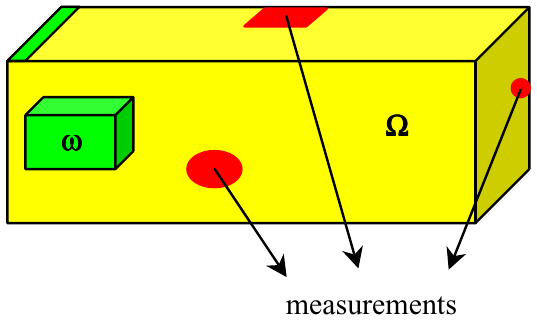
Figure 1. Domain Ω , regions ω , Г and locations of